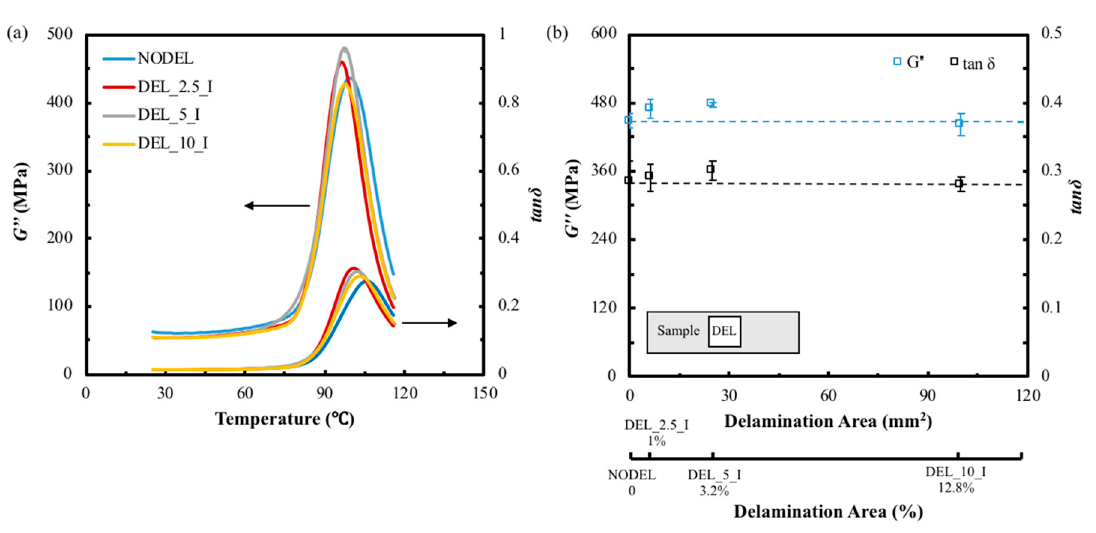
Figure 7. ( a ) Typical loss shear modulus and tan δ against temperature curves, ( b ) the loss shear modulus and loss factor of FFRP composites with different delamination areas.